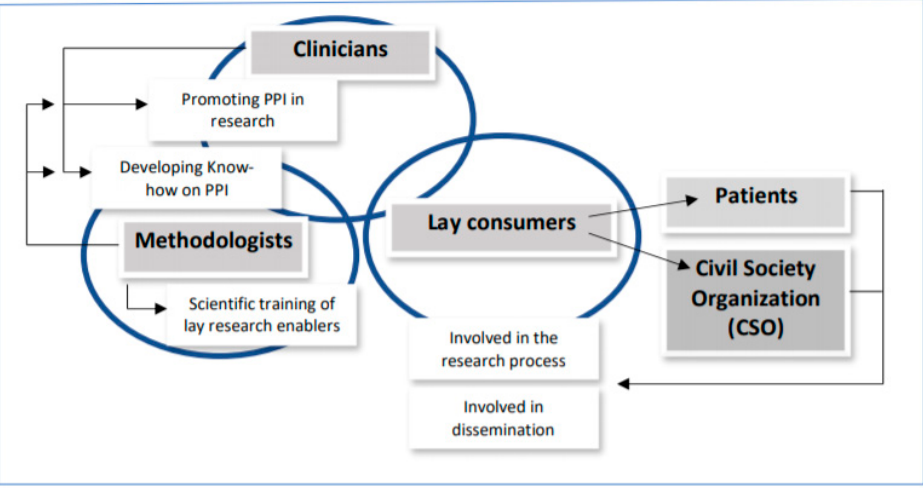
Figure 1. Key stakeholders and activities in public and participant involvement (PPI).